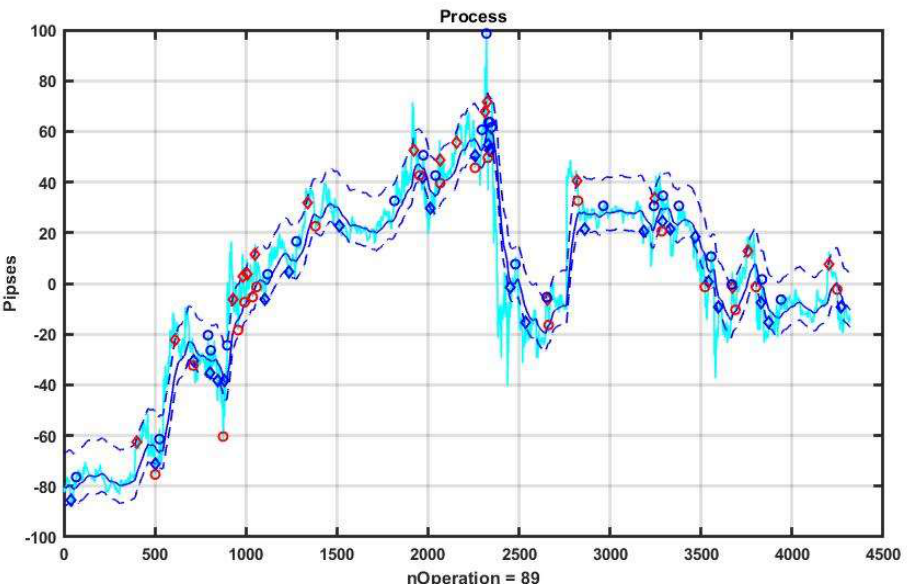
Figure 16. Example implementation of CSB with five optimized parameters on subsequent three- day interval.